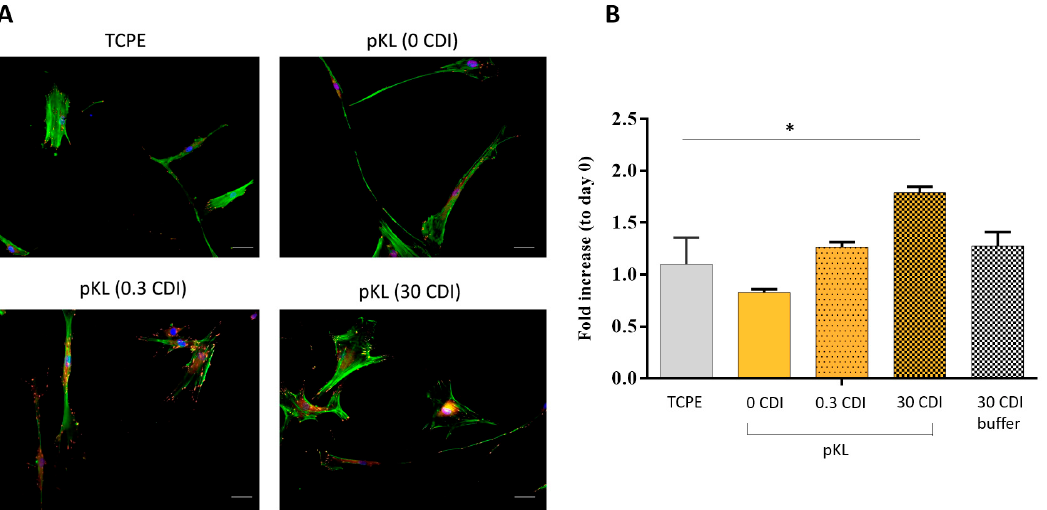
Figure 3. ( A ) Cytoskeleton organization of hMSC 24 h after seeding on TCPE control and pKL-SAMs after activation with different concentrations of CDI. Green: Actin filaments; red: vinculin; blue: nuclei. Scale bar: 50 µ m. ( B ) Cells metabolic activity 1 day after seeding, as index of cell adhesion. Data are expressed as average ± STDEV of three replicates per condition. * Statistically significant difference compared to TCPE surface (* p < 0.05) .